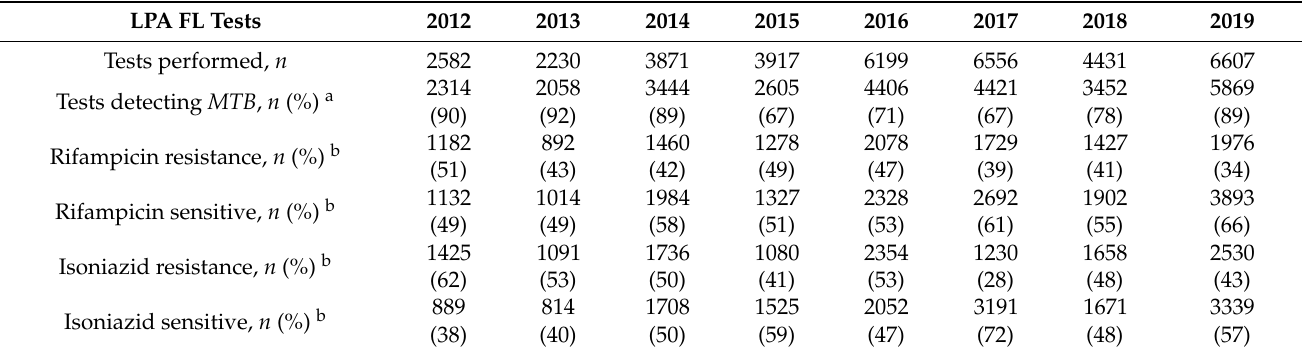
Table 3. Performance and results of first-line LPAs in Uzbekistan from 2012 to 2019.